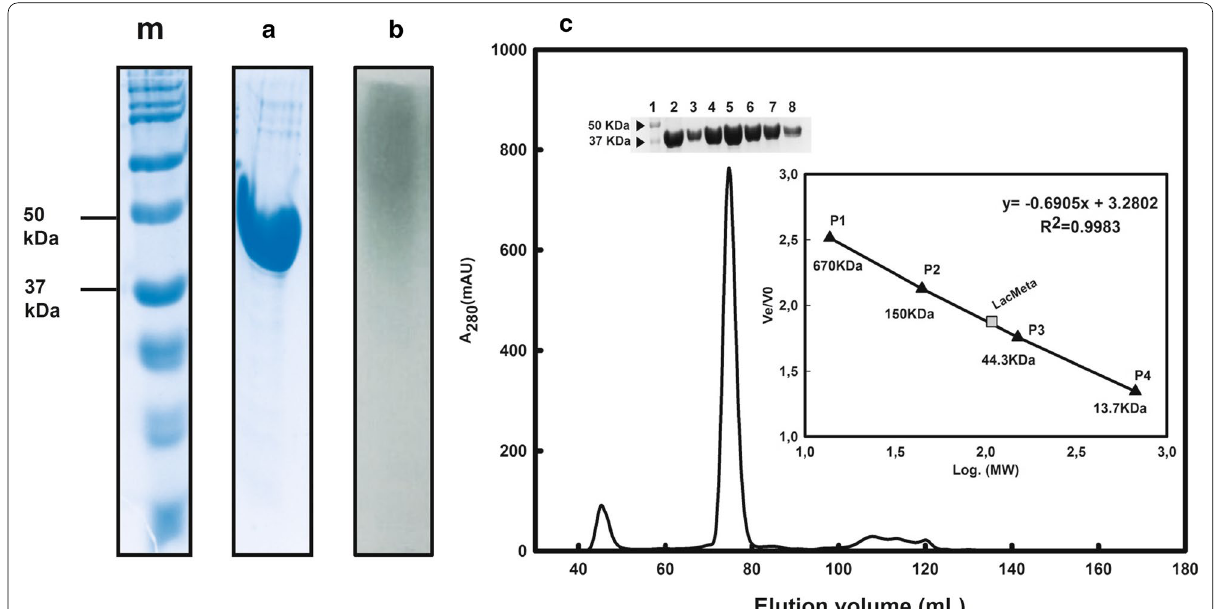
Fig. 2 LacMeta expression and purification. m) Molecular mass marker. a 10% SDS‑PAGE metal affinity purification fraction of the recombinant protein. b Native LacMeta gel stained with 1 mM of 2,2 ′ ‑Azino‑bis (3‑ethylbenzothiazoline‑6‑sulfonic acid), ABTS, in sodium citrate buffer pH 4.0. c Chromatographic profile of the gel filtration purified metagenomic. The internal image corresponds enzyme equivalent fractions purified laccase (2–8). Molecular mass estimation of LacMeta by gel filtration based on linear correlation. Elution of standard molecular mass of LacMeta and protein standards versus their logarithmic molecular mass values. P1–P4: Proteins used as molecular mass standards: ρ‑amino benzoic acid (pABA) (0.13 kDa), Ribonuclease A (13.7 kDa), albumin (43 kDa), (Bovine thyroglobulin (670 kDa), γ‑globulin (150 kDa), Protein Standard Mix 15